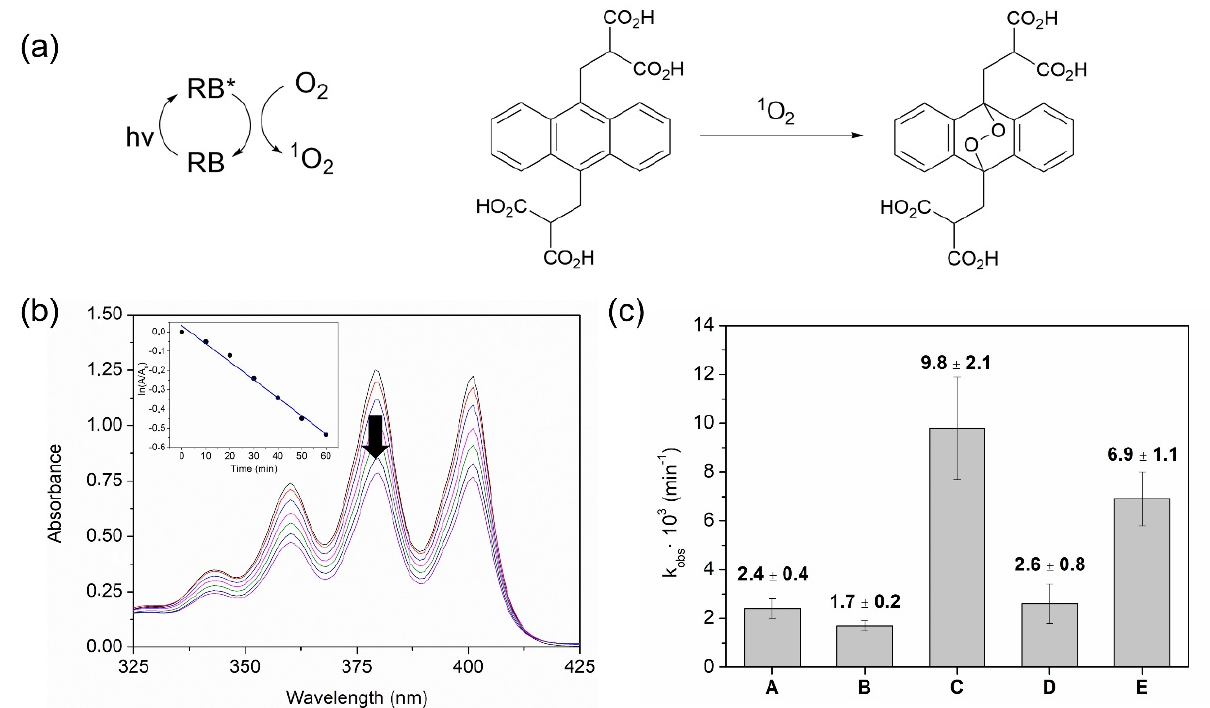
Figure 3. Generation of 1 O 2 by Irradiated PHEMA Films: ( a ) photosensitization cycle involving excitation of RB/energy transfer to oxygen and reaction of generated 1 O 2 with ABDA as chemical trap (arrow indicates the evolution of the absorption with time); ( b ) Representative change of the UV-vis absorption spectra of ABDA upon reaction with 1 O 2 ; ( c ) Calculated kinetic constants of the reaction between ABDA and 1 O 2 generated by different PHEMA films, where A: PHEMA; B: PHEMA(I), C: RB@PHEMA(I); D: PHEMA(Cl) and E: RB@PHEMA(Cl).